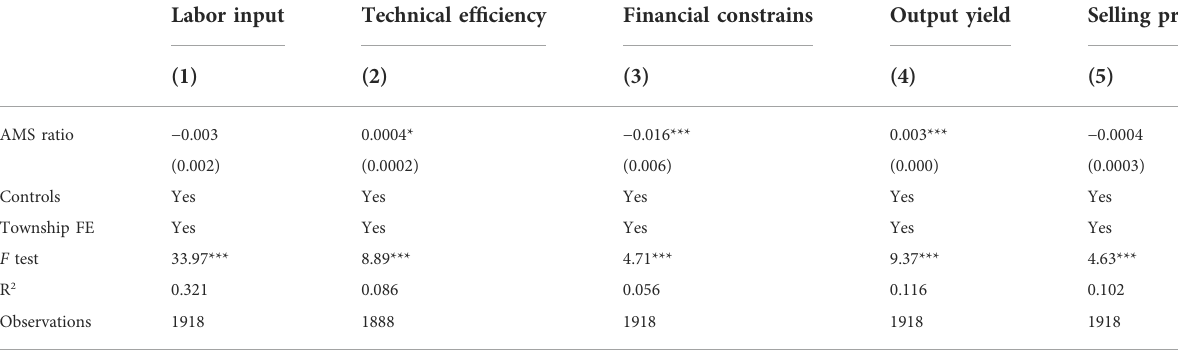
TABLE 5 Mechanism analysis: the effect of AMS on potential mechanisms,